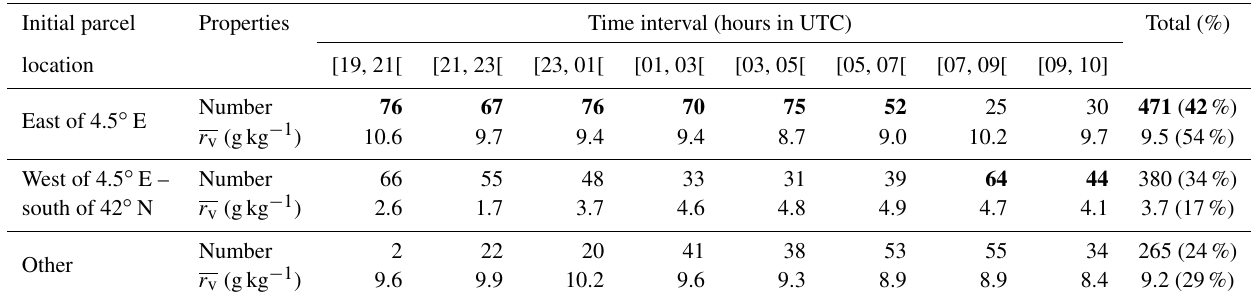
Figure 13. Instantaneous precipitation rate at 05:00UTC on 15 October superimposed on the terrain elevation of (a) REF and (b) NOALB simulations. Table 2. Properties and geographic origin of air parcels found in the atmospheric column C 338 as a function of time, aggregated in time intervals from 19:00UTC on 14 October to 10:00UTC on 15 October. Mean water vapour mixing ratio 2h before reaching C 338 (i.e. before some parcels are lifted) is indicated by r v . Bold values indicate the highest number at each time